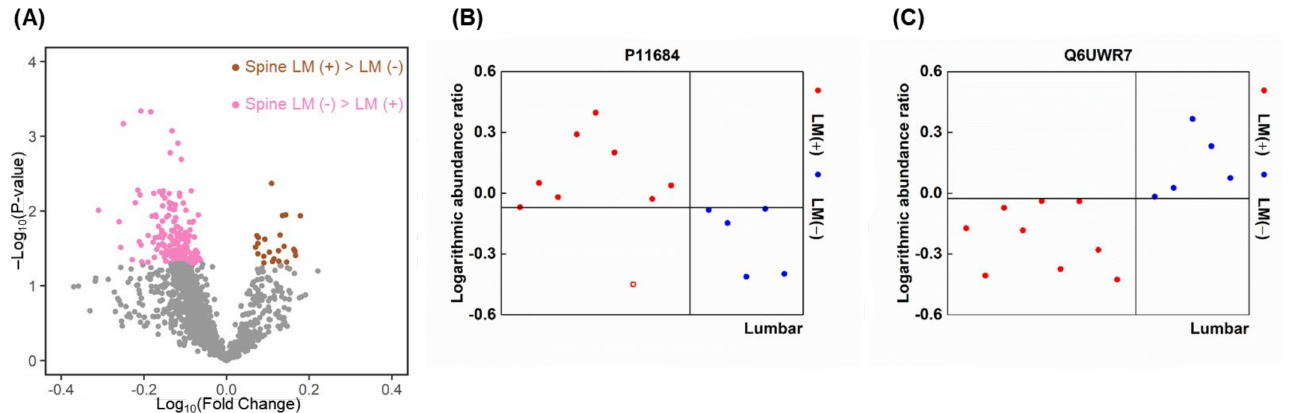
Figure 5. Evaluation of discriminative proteins between spinal LM (+) CSF and ( − ) lumbar CSF. ( A ) Volcano plot illustrating significantly discriminative proteins of each group. X-axis: Log 10 (mean abundance of spinal LM (+) samples/mean abundance of spinal LM ( − ) samples). Y-axis: –Log 10 (independent t -test p -value). Proteins with 2-group t -test p -value < 0.05 are presented in pink or brown color dots. An example of highly expressed protein in ( B ) spinal LM (+) samples and ( C ) spinal LM ( − )